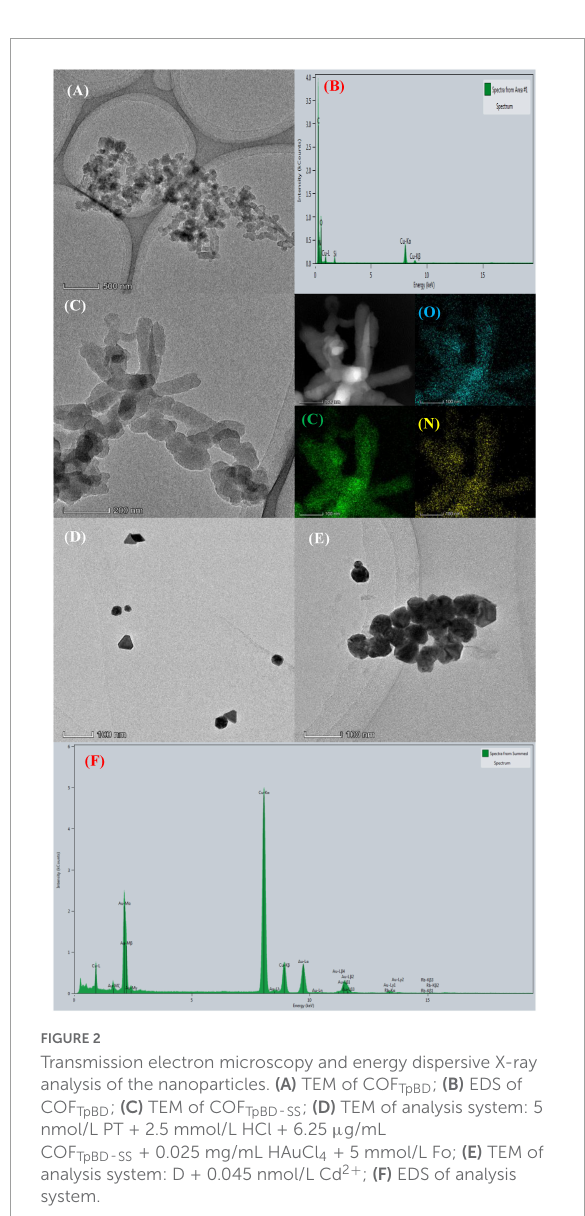
FIGURE2 Transmission electron microscopy and energy dispersive X-ray analysis of the nanoparticles. (A) TEM of COF TpBD ; (B) EDS of COF TpBD ; (C) TEM of COF TpBD - SS ; (D) TEM of analysis system: 5 nmol/L PT + 2.5 mmol/L HCl + 6.25 µ g/mL COF TpBD - SS + 0.025 mg/mL HAuCl 4 + 5 mmol/L Fo; (E) TEM of analysis system: D + 0.045 nmol/L Cd 2 + ; (F) EDS of analysis